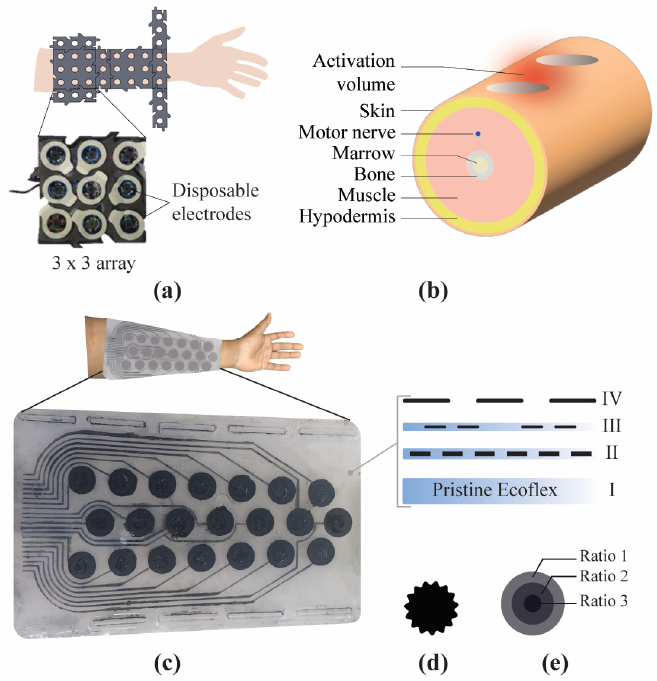
Figure 8. ( a ) Previous attempt of an electrode-array-based sleeve with disposable electrodes having a bulky construction. ( b ) Computational model of a forearm under transcutaneous stimulation. ( c ) Electrode-array-based sleeve fabricated using multilayered screen-printing process (in this study). ( d , e ) demonstrate that the fabrication process can allow for customizing the electrode elements in terms of shape and different materials.